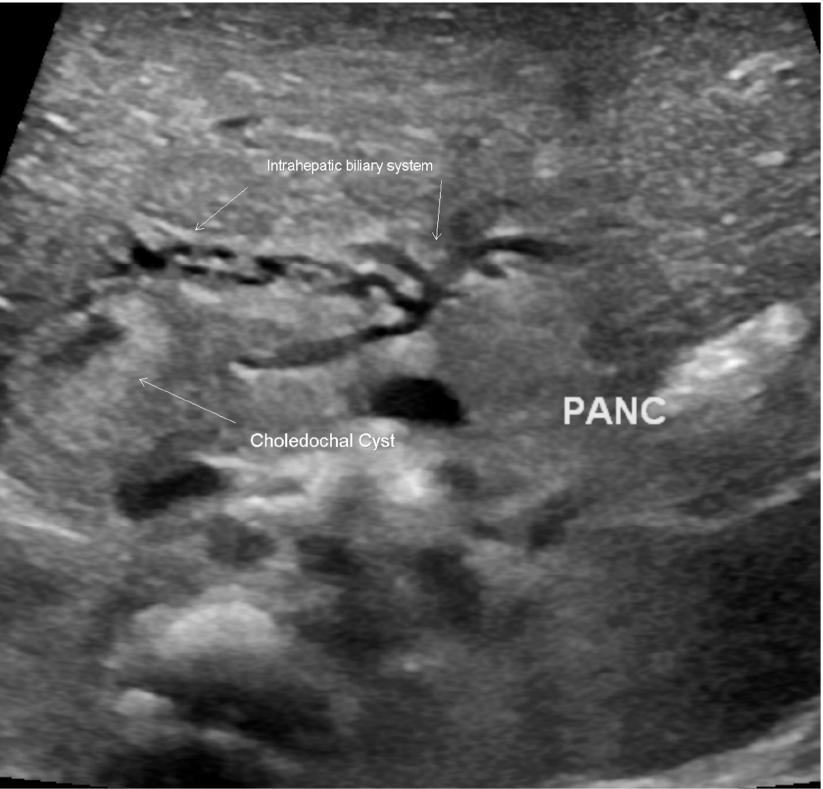
Figure 3. Ultrasound scan of the abdomen, revealing a choledochal cyst with dilatation of the intrahepatic biliary system.